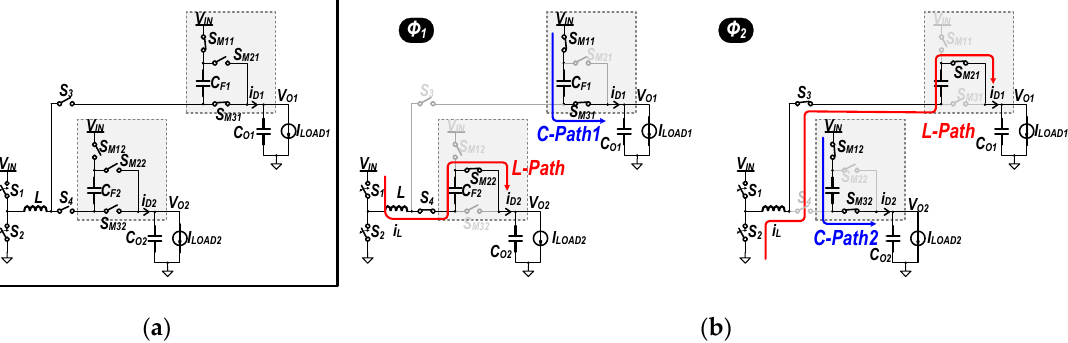
Figure 11. Topology ( a ) and operation ( b ) of a single-inductor dual-output buck converter with ETM.